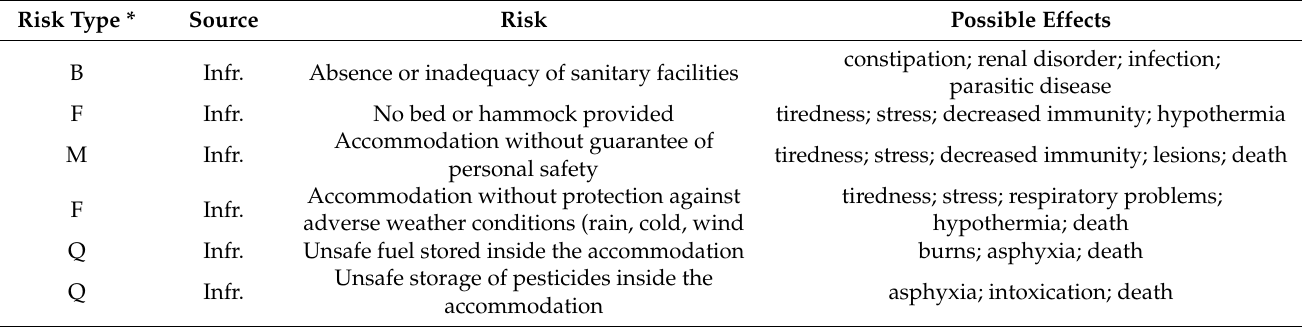
Table 2. Typical housing risks.